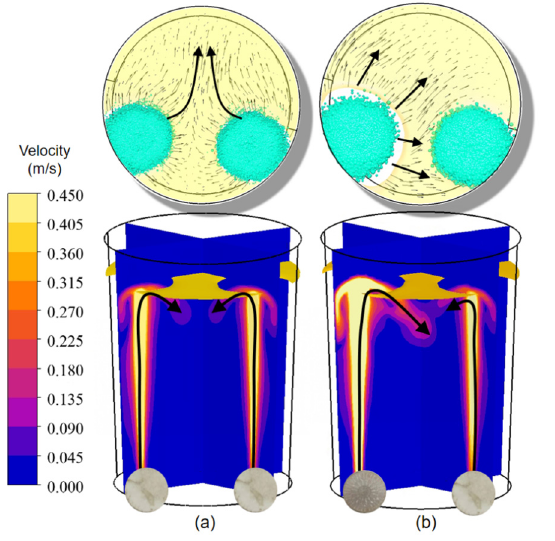
Figure 6. Velocity distribution in liquid steel and slag–metal interface: ( a ) P–P mode, ( b ) S–P mode.